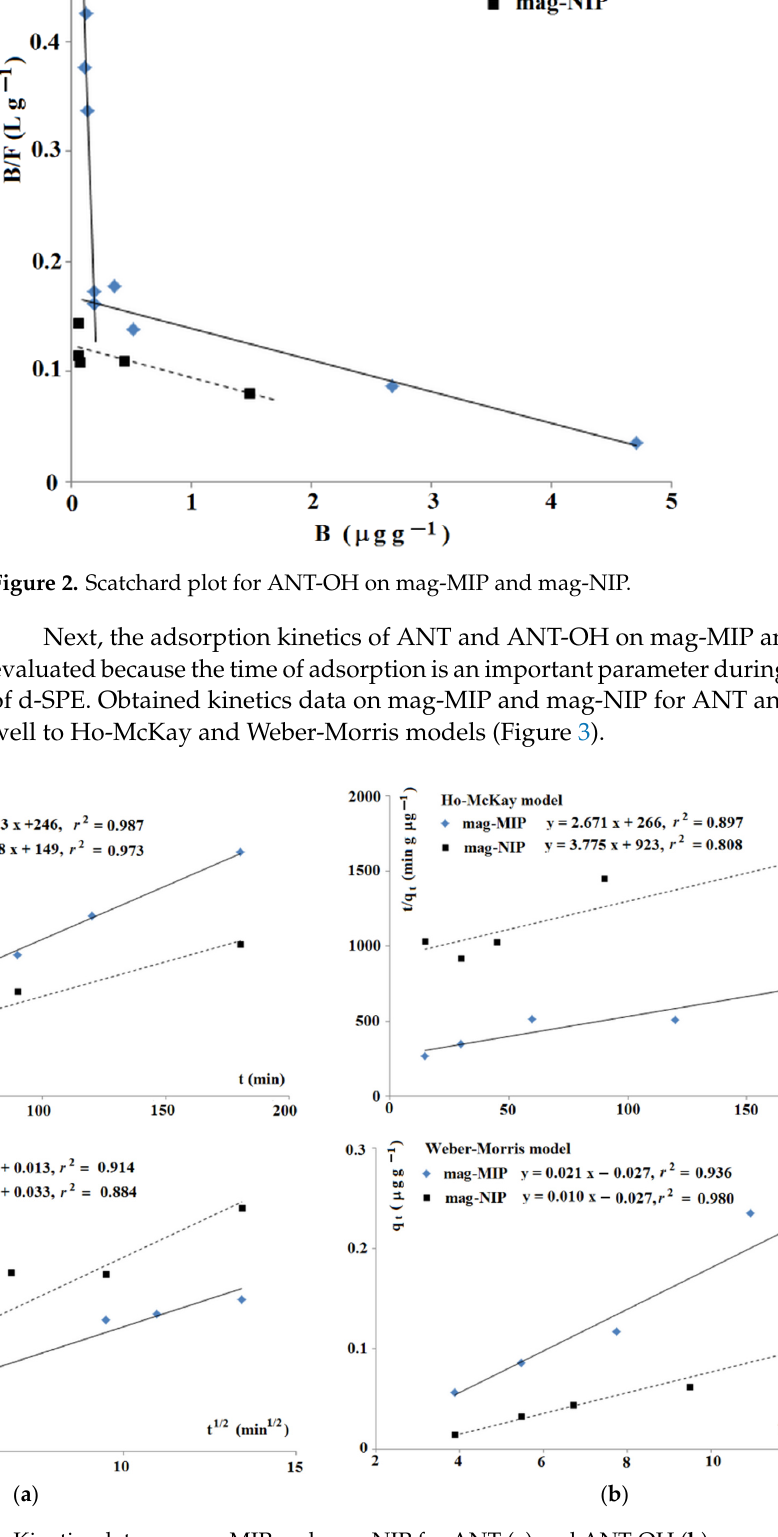
( b ) Figure 3. Kinetics data on mag-MIP and mag-NIP for ANT ( a ) and ANT-OH ( b ).